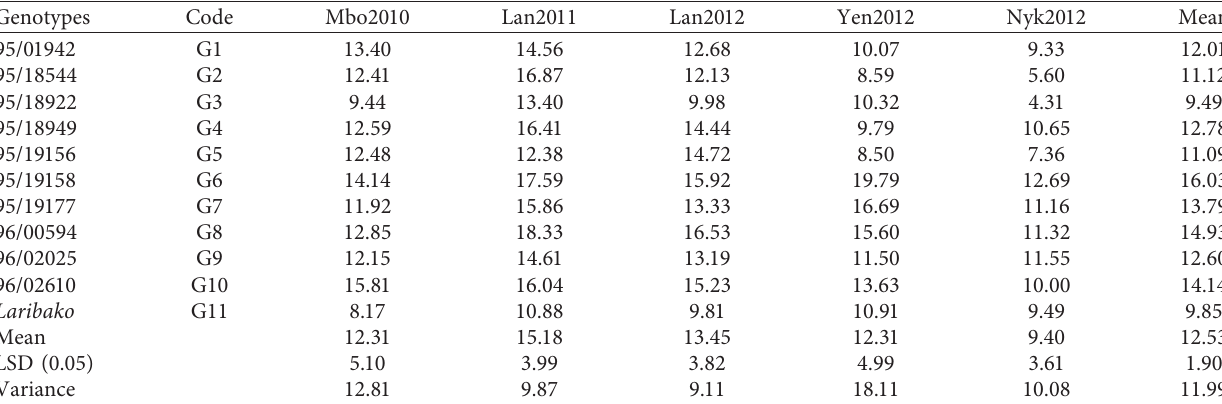
Table 4: Mean tuber yield (t ha − 1 ) of 11 elite yam genotypes evaluated in five environments. Genotypes